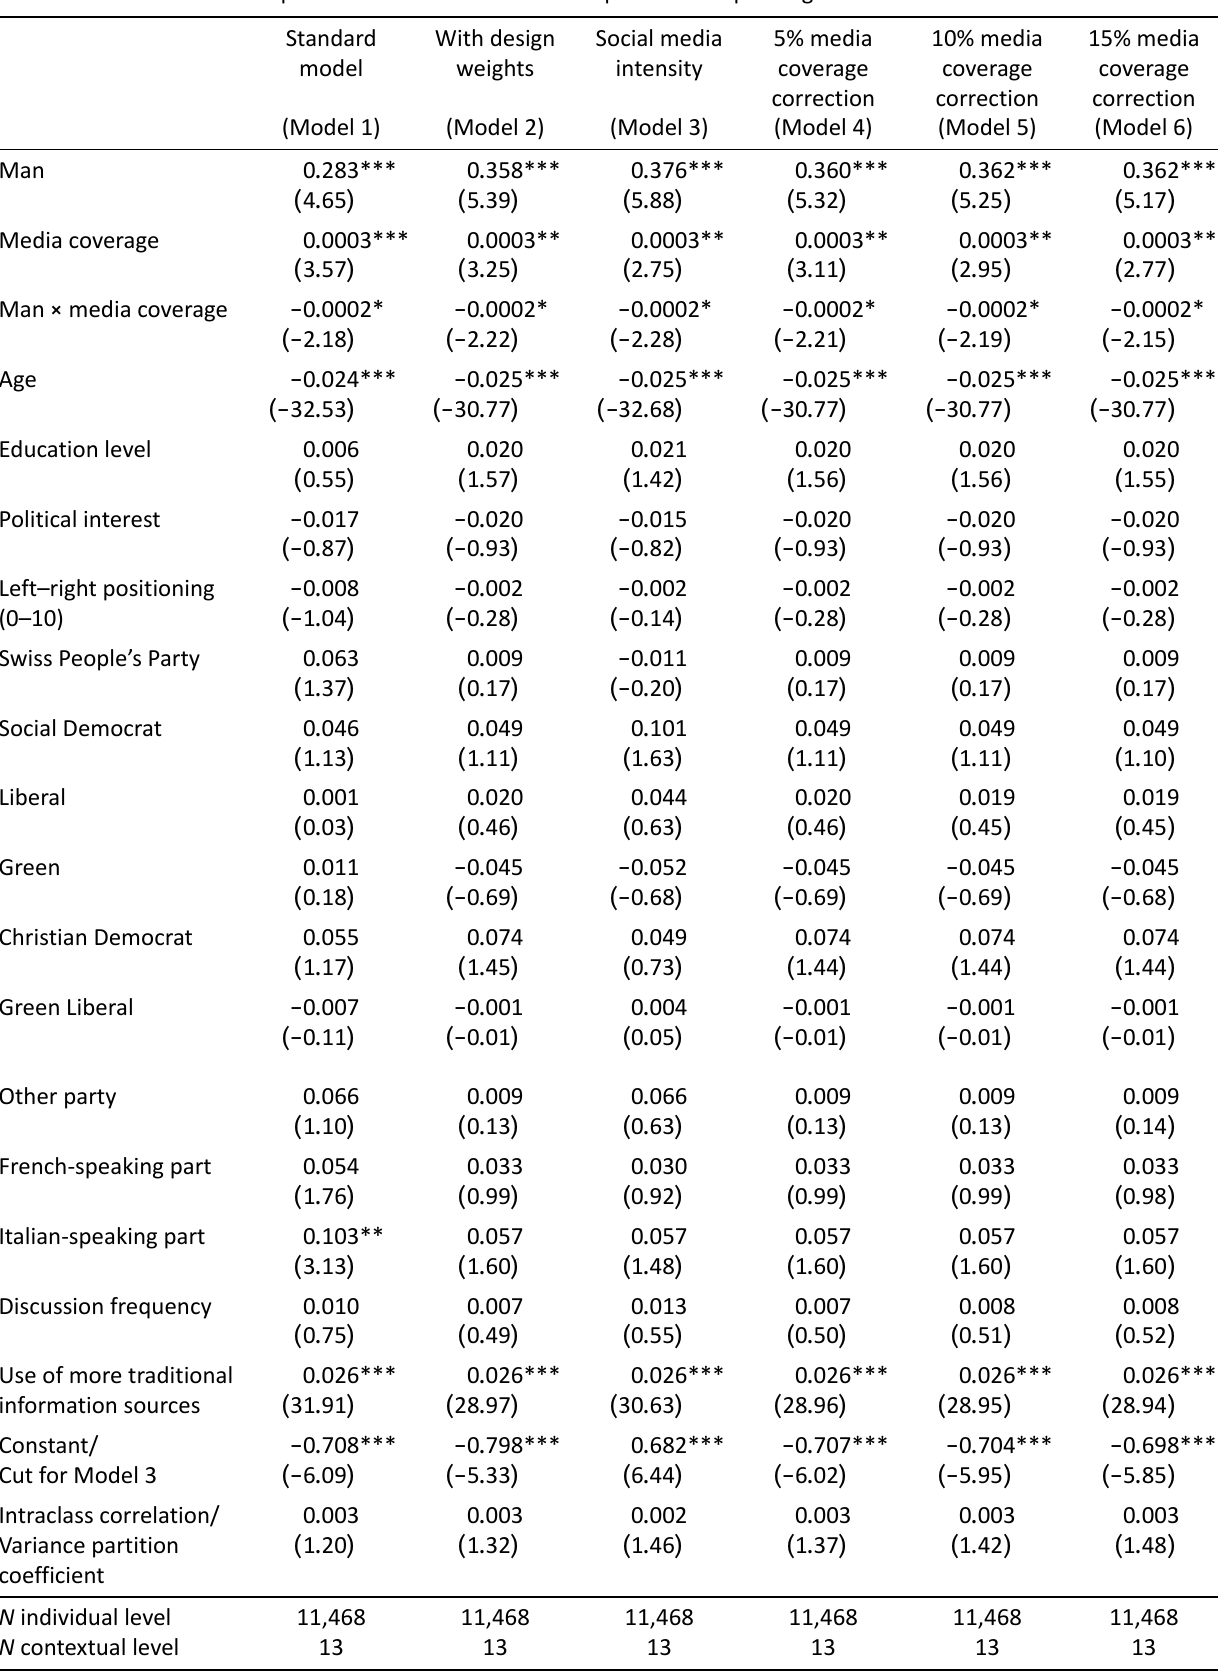
Table 3. Probit and ordered probit two‐level random‐intercept models explaining individual reliance on social